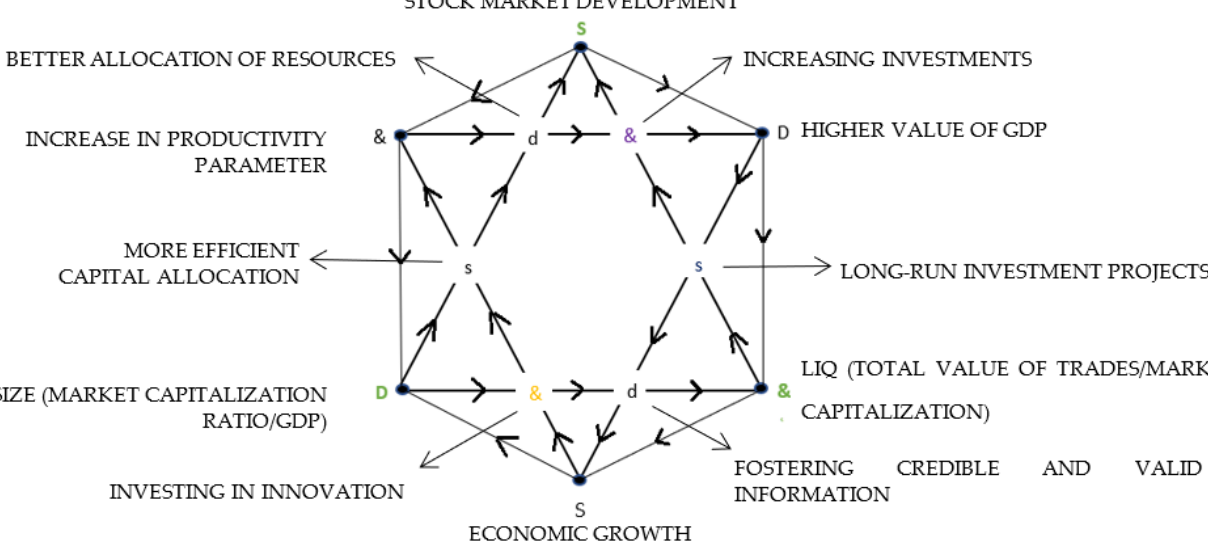
Figure 10. Using the stock market as a lever to foster economic growth, containing: a source (S), a sensor (&), and a decident (D), authors source.